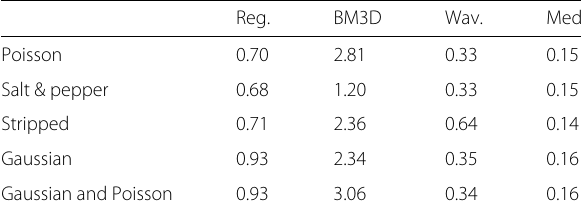
noise level, our regression denoising rate shows robust and better performance compared with the other three